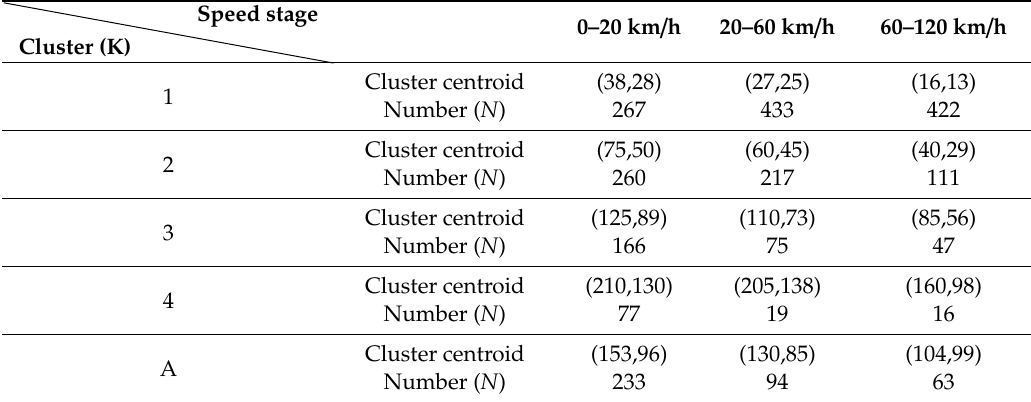
Table 4. Cluster centroids and number of vehicle sizes.